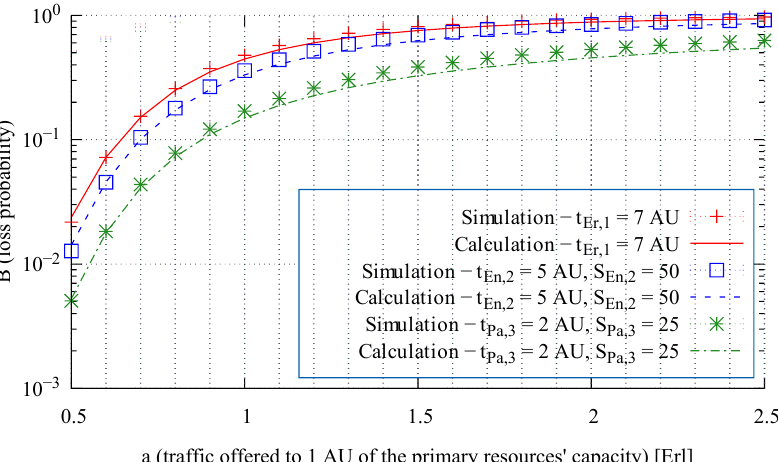
Figure 16. Loss probability (call congestion) of three selected traffic classes in the primary resources of System 2.